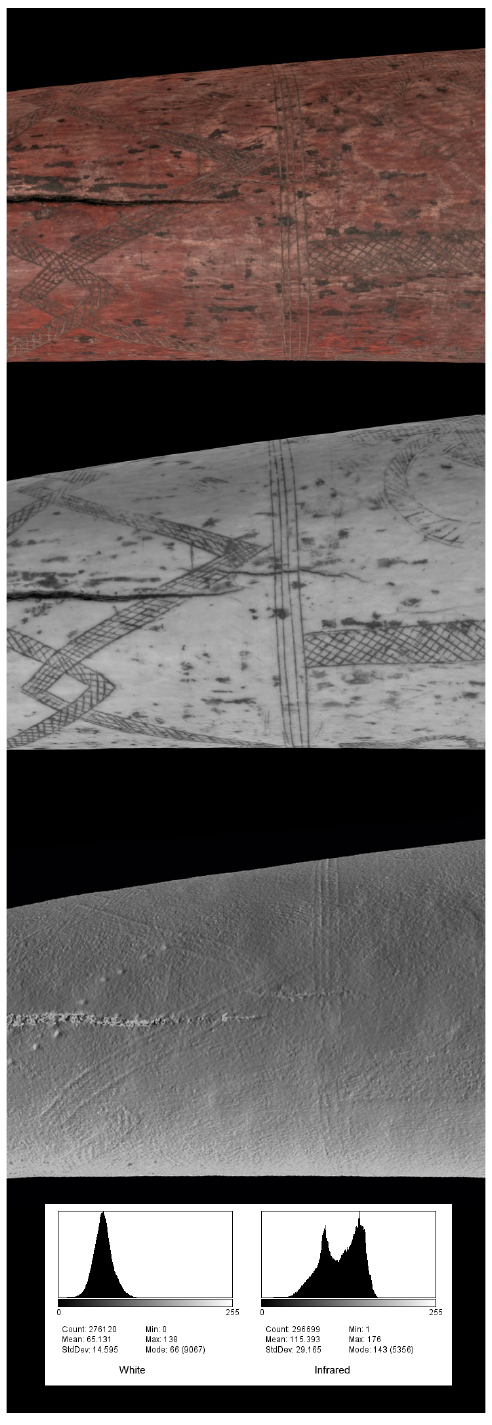
Figure 4: Detail of the horn with white light and IR texture and without texture. The IR model enhance the presence of some cracks that are less visible in white light and allow a better reading of the pattern than the mesh. Histogram of the white light and IR texture are situated at the bottom of the image showing a broader repartition of pixels for IR.